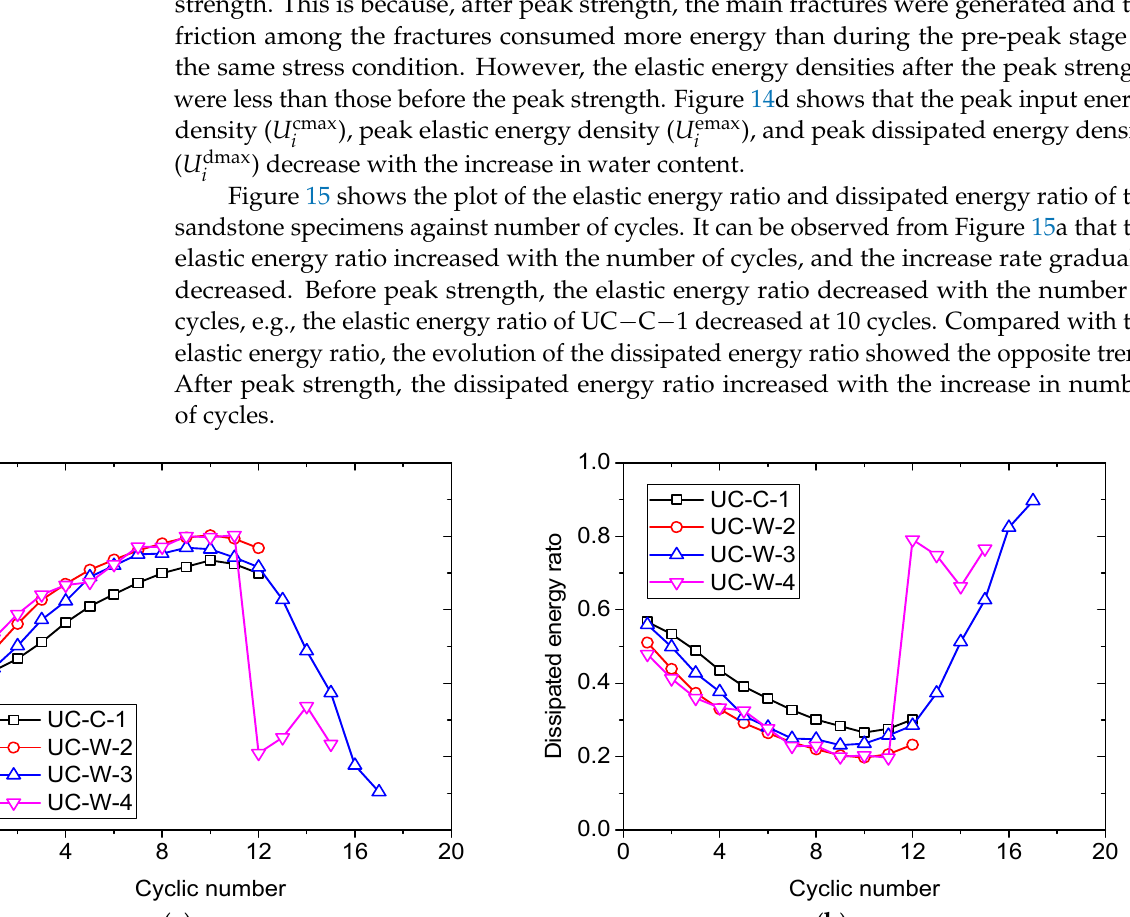
( b ) Figure 16. ( a ) Relationship between elastic energy ratio and unloading stress, and ( b ) the relation- ship between dissipated energy ratio and unloading stress.